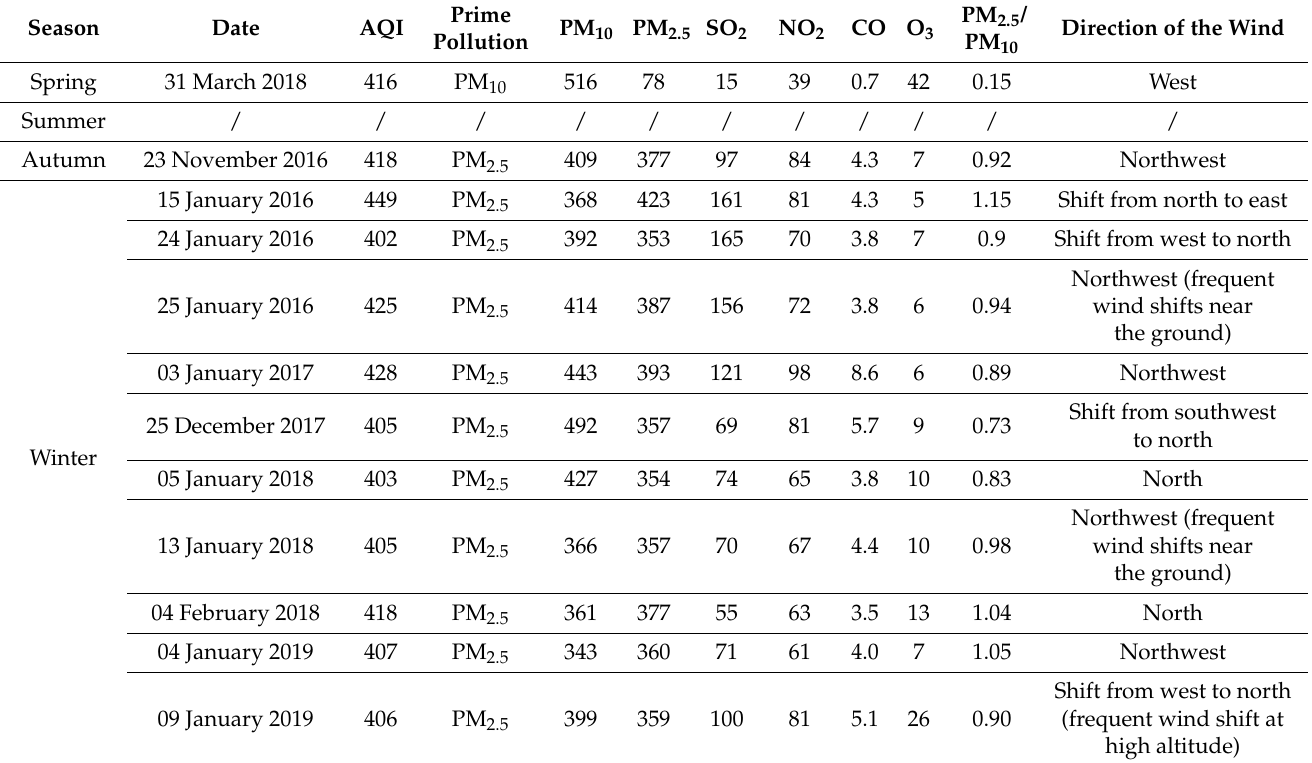
Table 4. Timeline of the heavy pollution